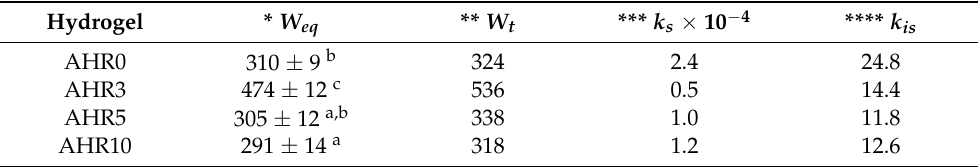
Table 1. Parameters of the swelling